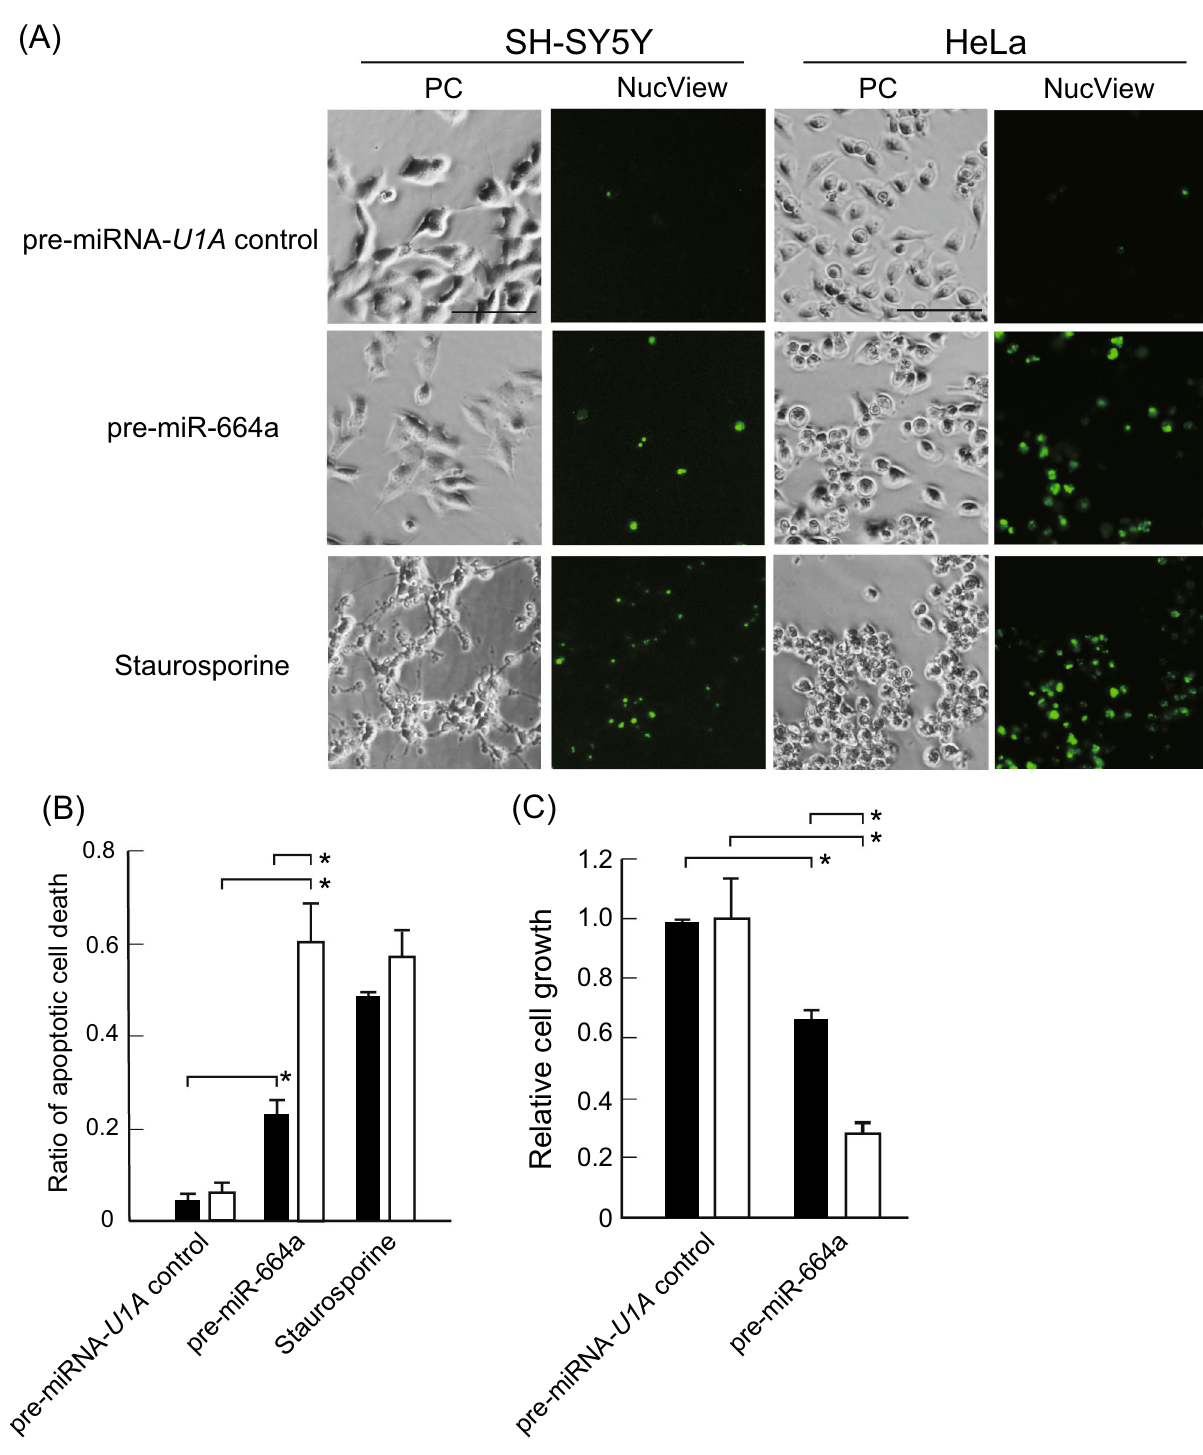
Figure 2. pre-miR-664a delivered by lipofection induces apoptosis. ( A ) SH-SY5Y and HeLa cells were transfected with pre-miRNA- U1A control or pre-miR-664a using Lipofectamine 3000. Apoptotic cells were detected using NucView 488 caspase assay kit. Staurosporine was used as a positive control. PC phase contrast images. Scale bars indicate 100 µm. ( B ) Apoptosis efficiency of SH-SY5Y (black bar) and HeLa cells (white bar) are shown. Data represent the means ± SEM of five independent experiments. *P < 0.01; two-way ANOVA and Tukey’s multiple comparisons test. ( C ) The growth of SH-SY5Y (black bar) and HeLa cells (white bar) transfected with pre-miRNA- U1A control or pre-miR-664a using Lipofectamine 3000. Data represent the means ± SEM of five independent experiments. *P < 0.05; P-values were calculated using two-way ANOVA and Tukey’s multiple comparisons